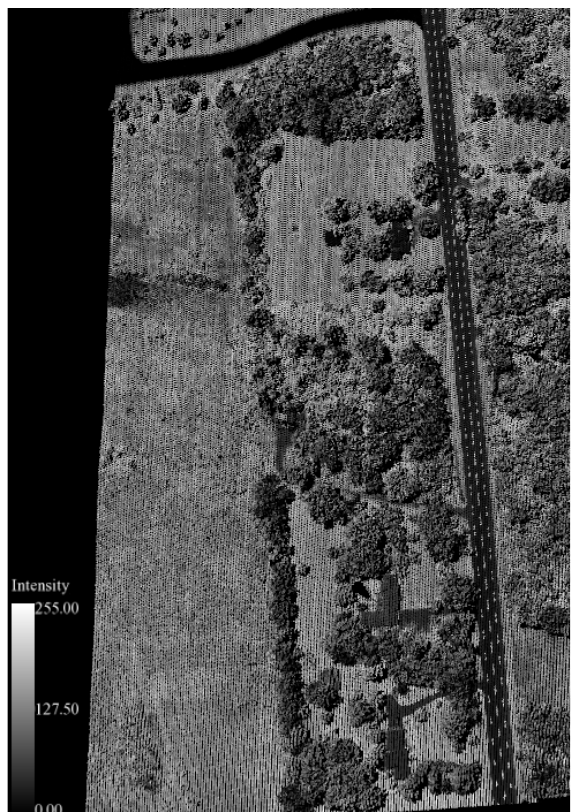
Fig.3 Point Cloud Data of the Experimental